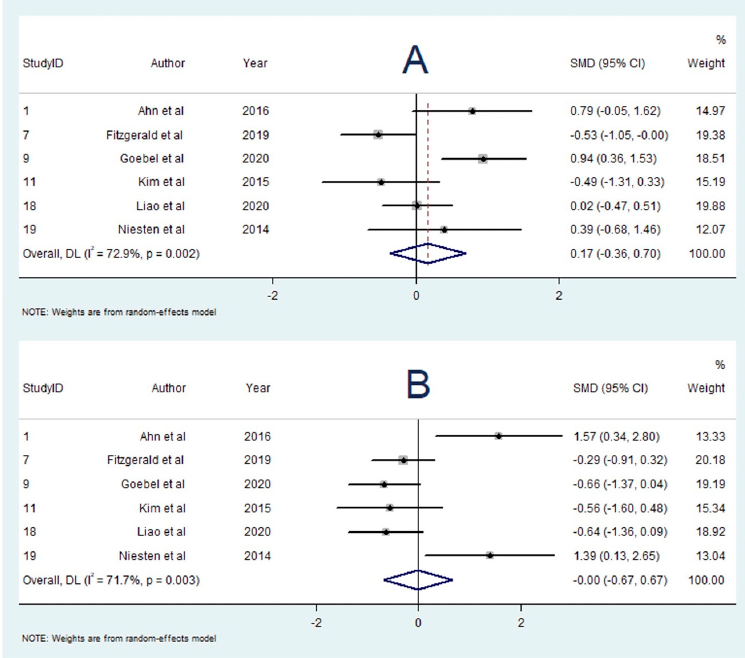
Figure 4. Forest Plots of Meta-analyses on Platelet Content and Aetiology. ( A ): Cardioembolic vs. LAA Stroke. ( B ): Cryptogenic vs. LAA Stroke. Abbreviations: DL: DerSimonian and Laird method, SMD: Standarized Mean Difference, CI: Confidence Interval, LAA: Large Artery Atherosclerosis.